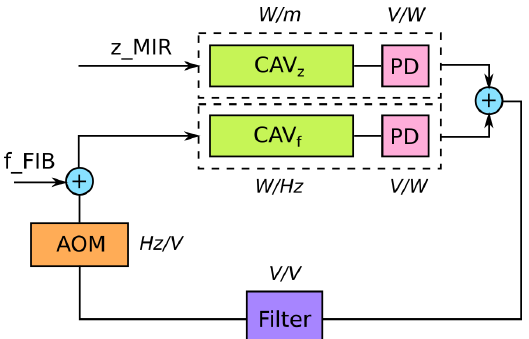
Figure 8. Scheme of the arm cavity control loop. The green boxes represent the transfer function of the optical cavity both for a frequency and a length change. The pink boxes represent the transfer function of the photodetectors (PD), the purple one the control filter, and the orange one the transfer function of the actuator (AOM). In the scheme the noises are explicitly shown at their entrance point: Through the mirrors of the cavity (z MIR ) and through the laser beam itself (f FIB